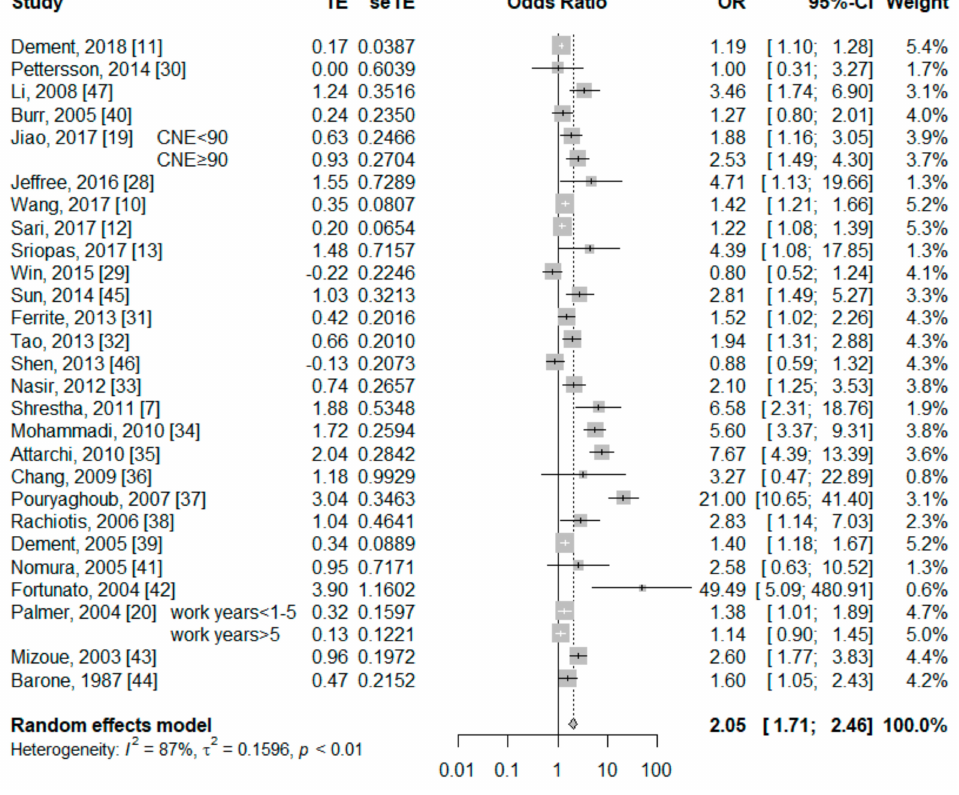
Figure 2. Forest plot for the association between current smokers and NIHL